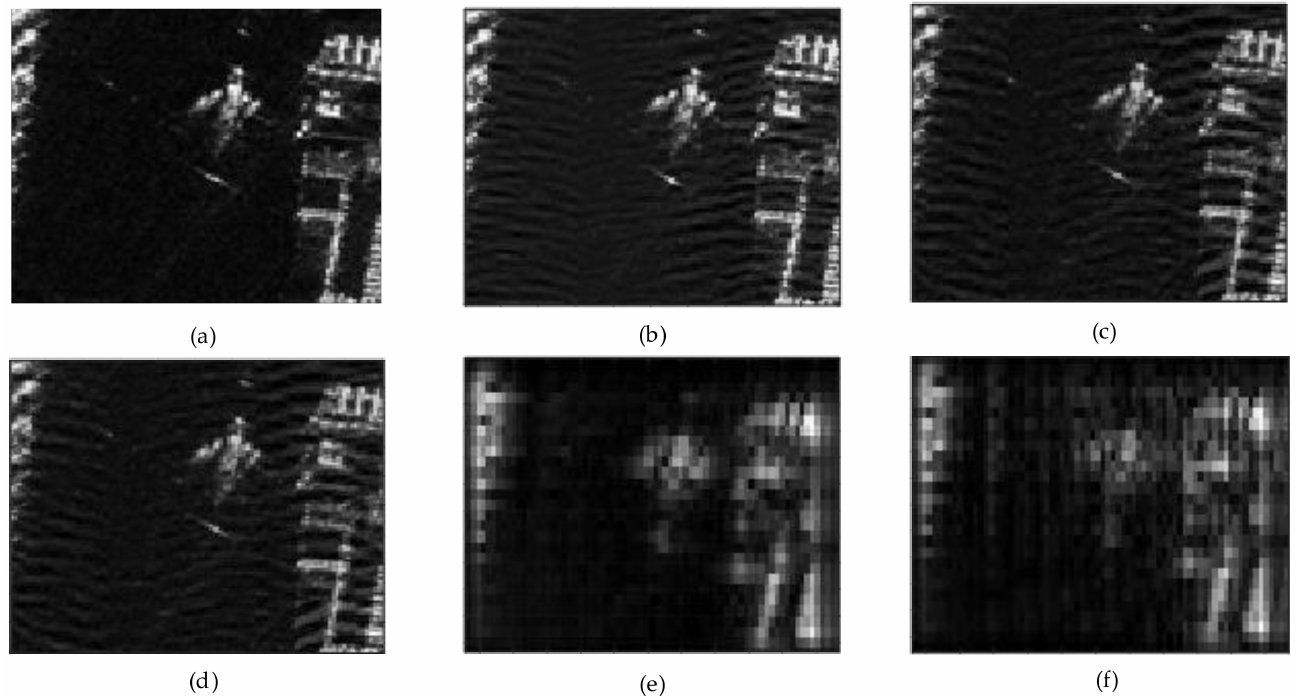
Figure 8. Plane target imaging results. ( a ) is original plane target, ( b ) is our proposed method with L = 3, ( c ) is our proposed method with L = 8, ( d ) is our proposed method with L = 11, ( e ) is ISTA method and ( f ) is Fast ISTA method.